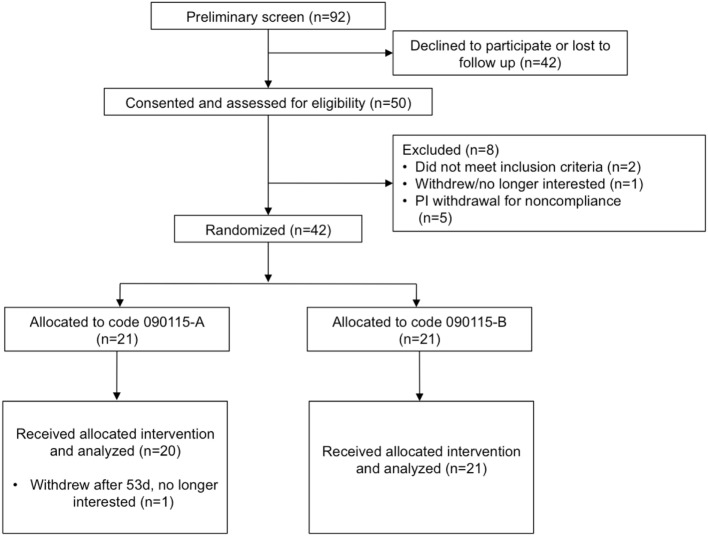
Study flow diagram to illustrate the number of subjects that were screened, consented, and randomized. Code 090115-A was used for the placebo, whereas Code 090115-B was used for Lactobacillus johnsonii N6.2.